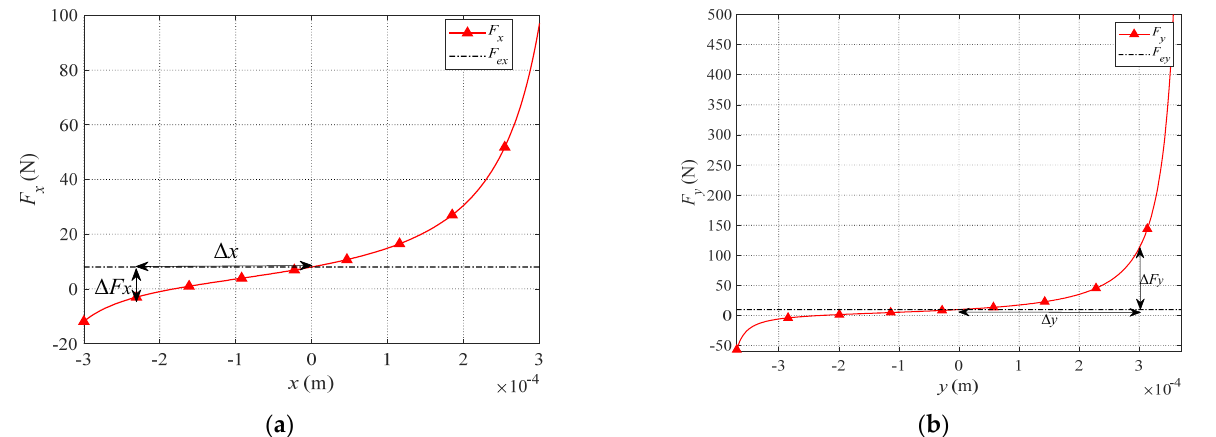
Figure 4. Curves of the relationship between F x and x that is illustrated in ( a ) and relationship between F y and y that is illustrated in ( b ).